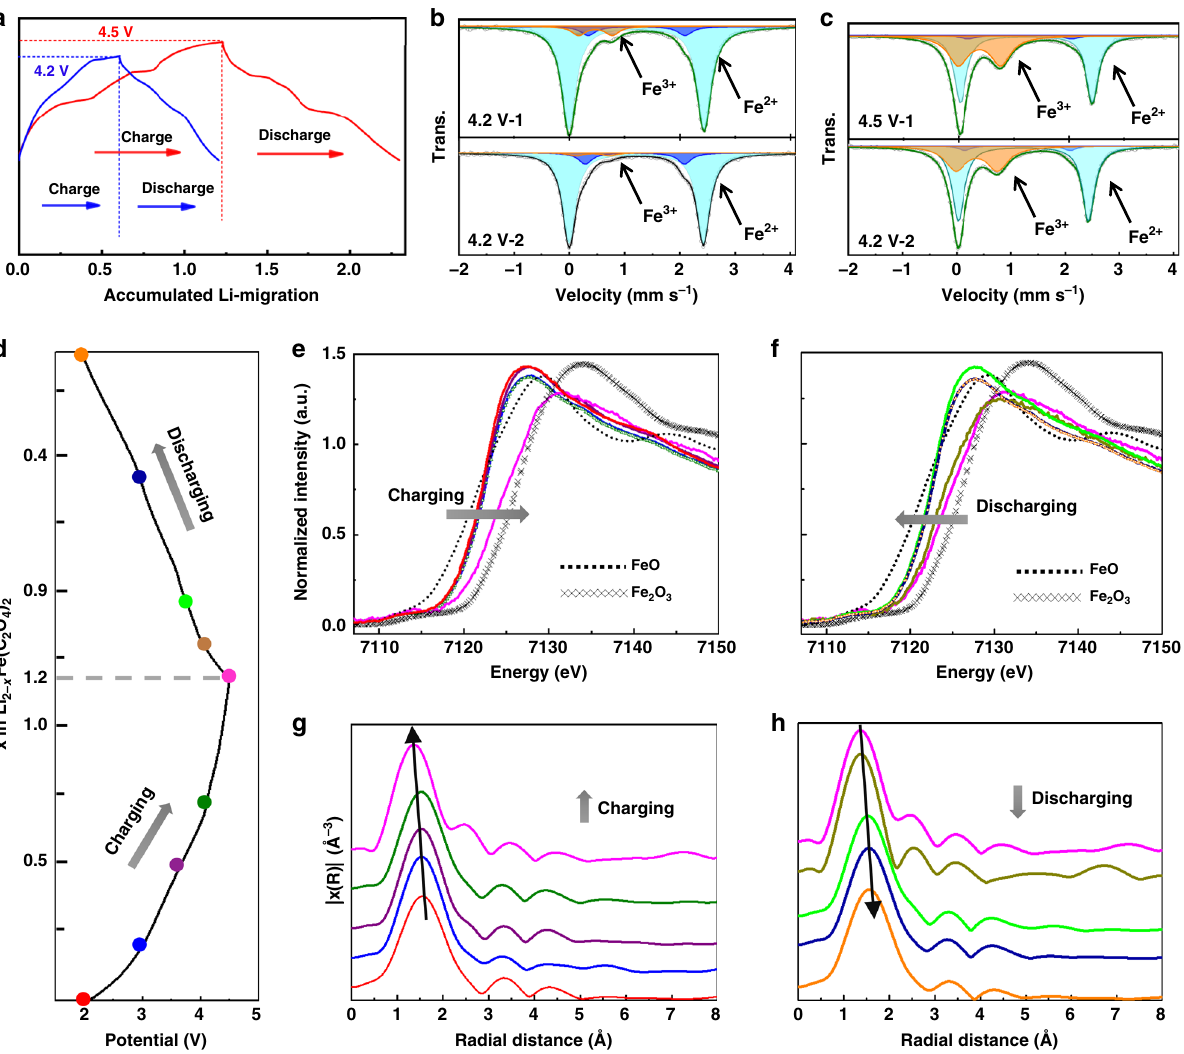
Fig. 2 Electrochemistry and evolution of iron in the stabilized cycling process. a Typical galvanometric charging and discharging curves of stabilized half cells in the window of 2.0 – 4.2 V (blue line) and 2.0 – 4.5 V (red line) at a current density of 10 mA g − 1 . Mossbauer patterns of recovered electrodes after charging to 4.2 V ( b ) and 4.5 V ( c ). The up and bottom patterns in (B) and (C) correspond to different batches of samples at 4.2 V-charged and 4.5 V- charged states, respectively. The consistency of each pair veri fi es the repetition of the measurements. The light blue, black, and orange- fi lled curve represents Fe 2 + in LFOx, Fe 2 + in trace amount of impurity, and new Fe 3 + , respectively. d Load curve for in-situ cell and corresponding synchrotron Fe K - edge XANES during the charge ( e ) and discharge ( f ), and Fe EXAFS during the charge ( g ) and discharge ( h ). The curves in different colours in ( e – h ) re fl ect the chronological states highlighted by circles in the same colour in ( d ), namely red, blue, purple, olivine, pink, dark yellow, green, navy blue and orange. FeO and Fe 2 O 3 were used as references for Fe K -edge XANES, as indicated by black dotted and grey crossed lines in ( e , f ). The olivine curve in ( e ) is represented by dashed line to avoid complete overlap with blue one. Same operation was applied to navy blue and orange curves in ( f ). The Fe EXAFS spectra in ( g , h ) were cascaded vertically to give a better clarity. The black arrows in ( g , h ) show the decrease and increase of Fe – O bond length